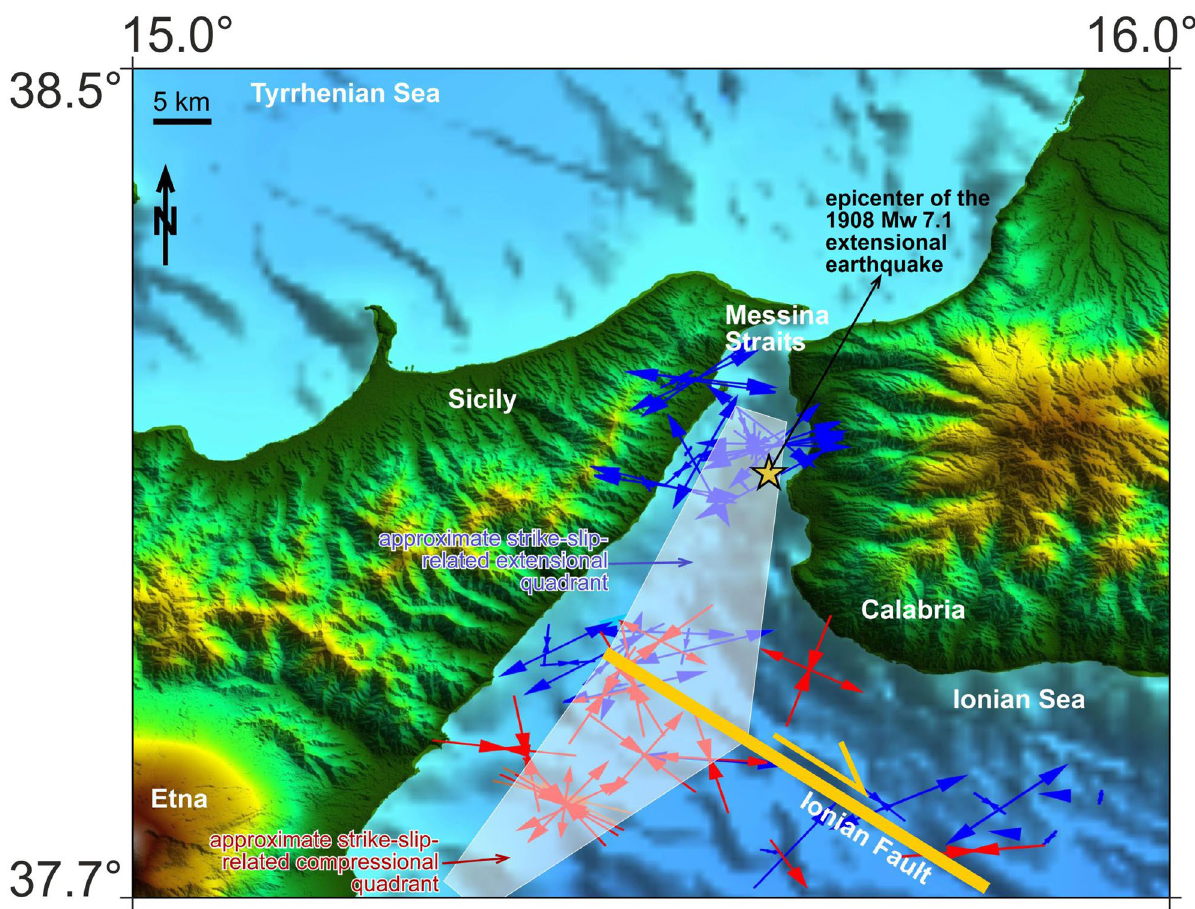
Figure 7. Map of the Messina Straits area with the northwestern termination of the right-lateral strike- to oblique-slip Ionian Fault. In this area, most extensional earthquakes (see the related T-axes in blue) are located in the northern extensional quadrant of the fault tip, whereas most compressional earthquakes (see the related P-axes in red) are located in the southern compressional quadrant of the fault tip (e.g., 54 ). Hence, we propose that the ongoing extensional regime in the Messina Straits and related earthquakes (including the 1908 one) may at least in part be driven by the right-lateral displacement along the Ionian Fault rather than by the regional stress field. The epicenter of the extensional 1908 earthquake is from Michelini et al. 69 . Morphobathymetric data are from Global Bathymetry and Elevation Digital Elevation Model: SRTM30_PLUS v8 (https ://data.gov.au/ data/datas et/globa l-hills hadin g-from-srtm3 0_plus-v8-0-nerp-te-13-1-eatla s-sourc e-ucsd/). The plot was edited using Corel Draw 2018 (Version 20.0.0.633; http://www.corel